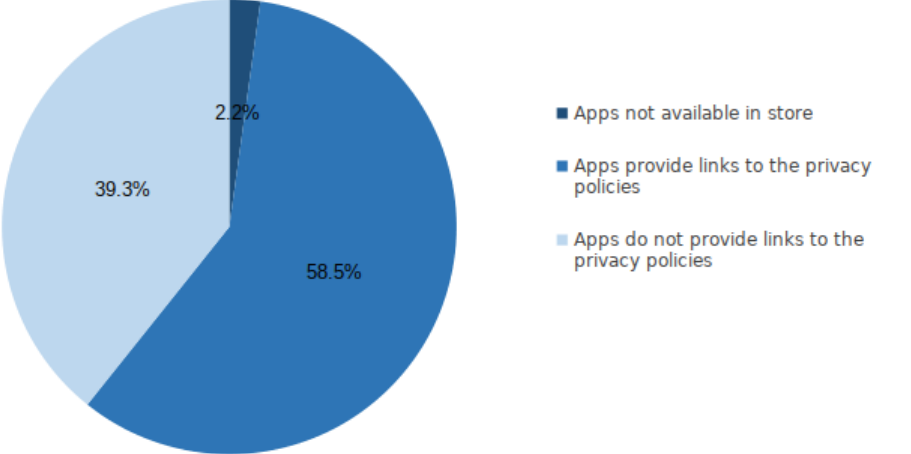
Figure 3. Overview of the availability of privacy policy links in iOS App store.